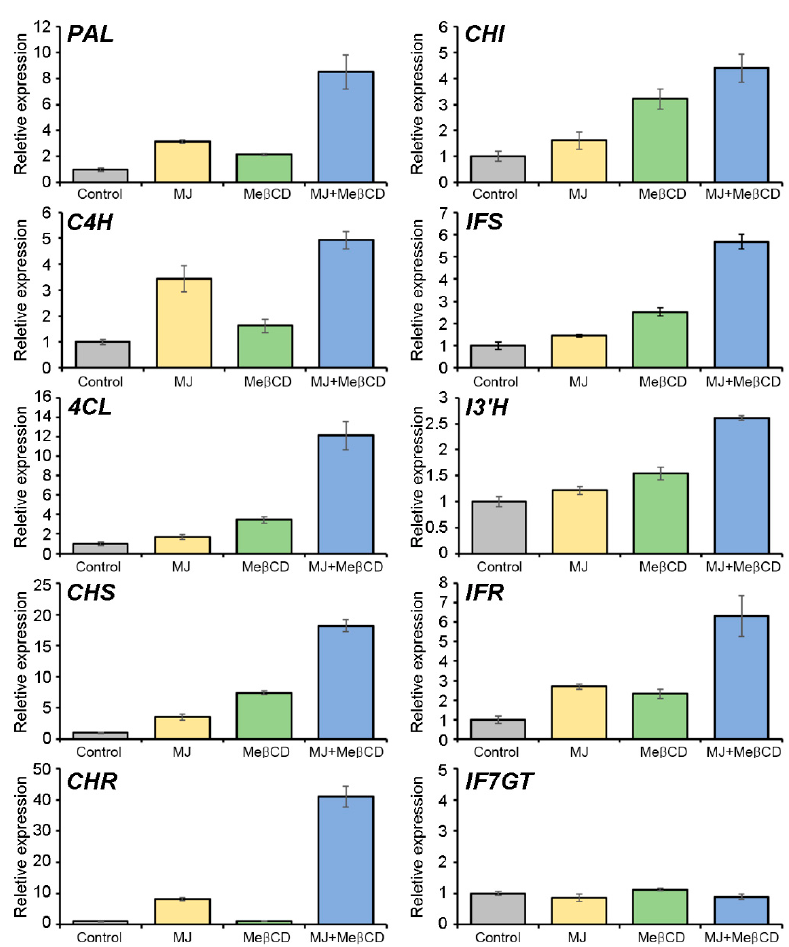
Figure 5. Relative expression of the pterocarpan biosynthetic genes in the S. flavescens cells elicited by MJ, methyl- β -cyclodextrin (Me β CD), and MJ + Me β CD. Transcript levels of PAL, C4H, 4CL, CHS, CHR, CHI, IFS, I3’H, IFR , and IF7GT were analyzed by qRT-PCR, using S. flavescens cells elicited with 50 µ M MJ, 50 mM Me β CD, or 50 µ M MJ + 50 mM Me β CD for 24 h. The relative expression levels were normalized to that of actin ( SfACT11 ; transcript ID: Sf128341_c1_g1_i1 ) as a quantitative control, and have been presented as the fold induction relative to the control. Data are the mean of three independent replicates ± SD.